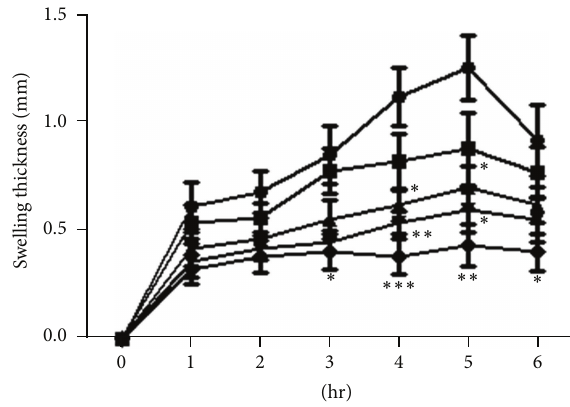
Figure 2: Inhibitory effect of patuletin on carrageenin-induced hind-paw edema in mice. Drugs were administered p . o . 30 min